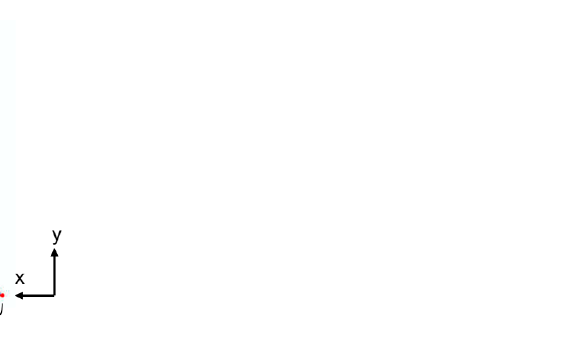
Figure 17. Schematic of thickness measurement along the rolling direction (RD), diagonal direction (DD), and transverse direction (TD) at three different regions: (I) cup bottom, (II) cup corner, and (III) cup wall for AA1050-O.